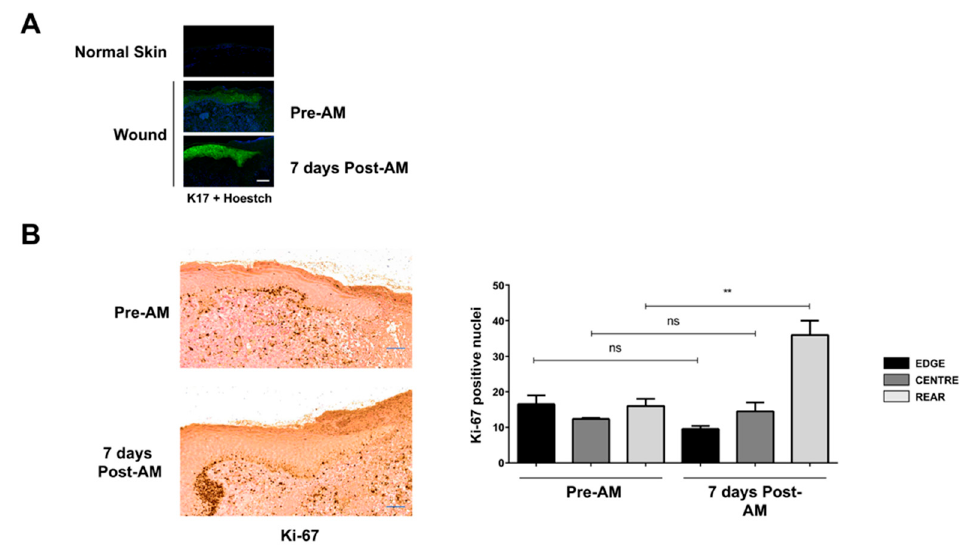
Figure 9. Amniotic membrane effects on chronic wounds correlate well with the observation obtained in vitro on HaCaT persistently exposed to TGF- β . Immune-histological study of human samples obtained from the edge of chronic wounds before and after amniotic membrane treatment. ( A ) Analysis of the keratinocyte activation using keratin-17 labeling (green). Nuclei are colored blue. ( B ) Analysis of the keratinocyte proliferation using Ki-67 labeling (brown deposits). Replicates from three independent samples were analyzed. Shown data represent mean ± SEM. Asterisks denote statistically signi fi cant di ff erences (** p < 0.005). The scale bar equals 200 µm; ns, non-signi fi cant.